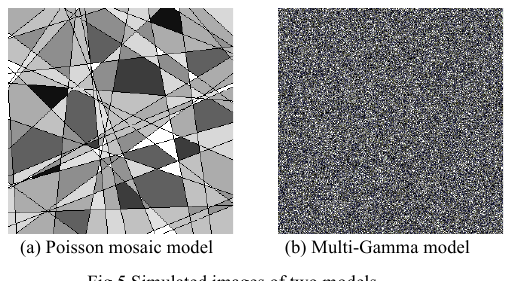
(a) r g = r m = 30 pixels